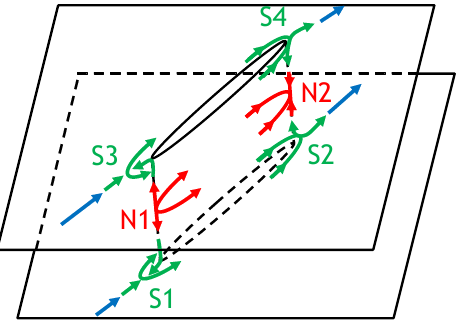
Figure 8. Topology without separation of a blade surface bounded on both sides.